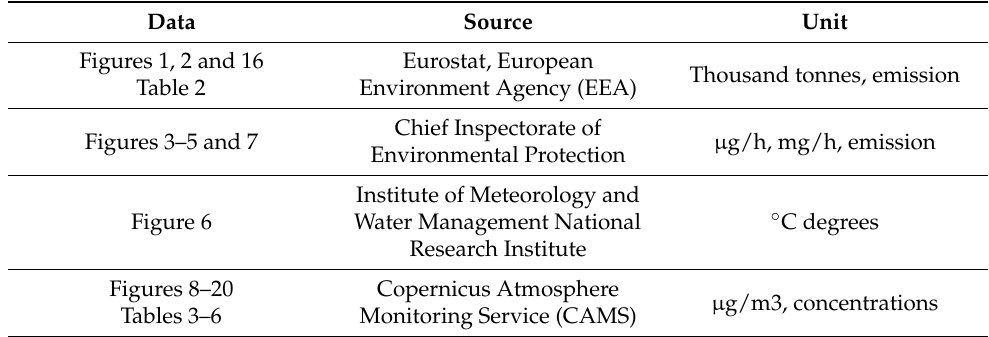
Table 1. Data sources used to conduct the presented